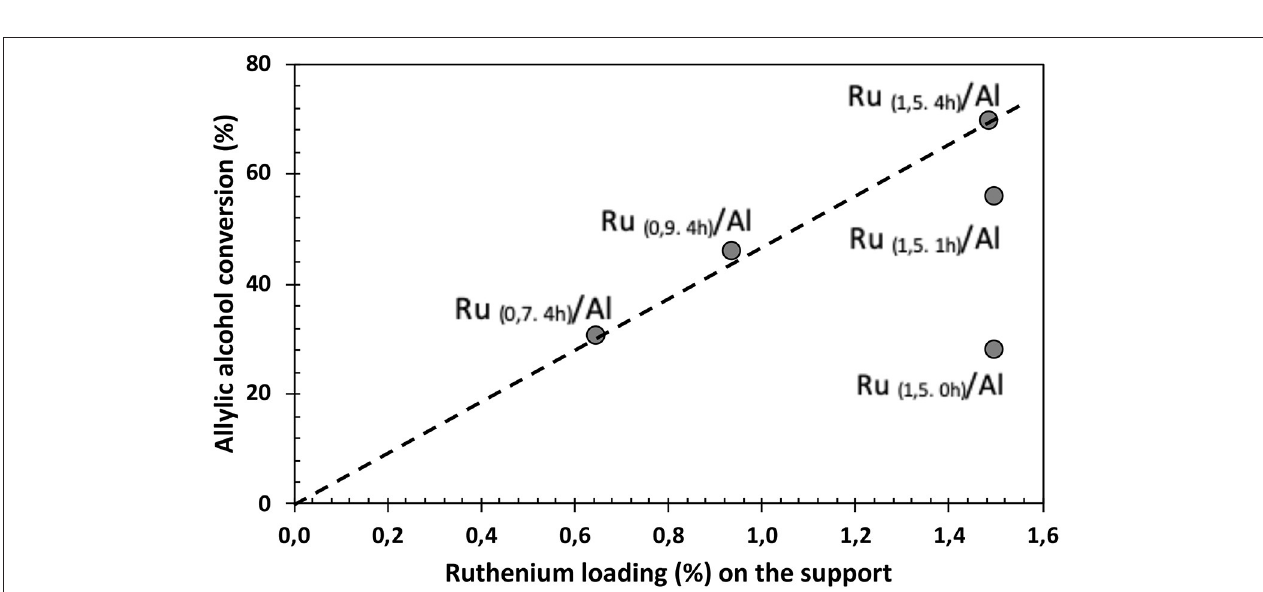
FIGURE 9 | Correlation between the percentage of conversion of allyl alcohol and the loading (%) of Ru in the synthesized solids.